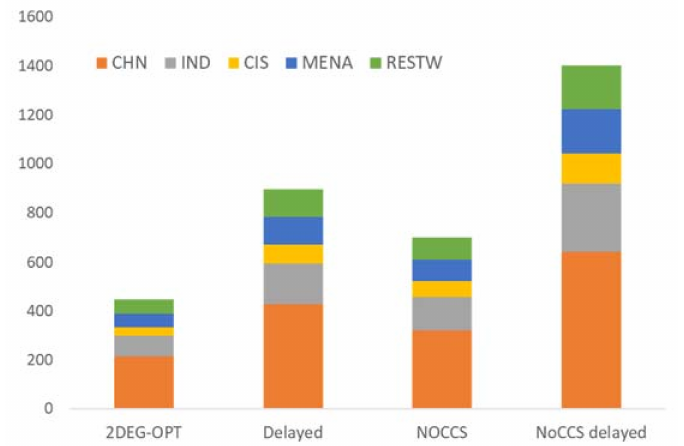
Figure 9. Stranded power generation assets (cumulative over 2020–2050) in developing countries in alternative scenarios (in GW).